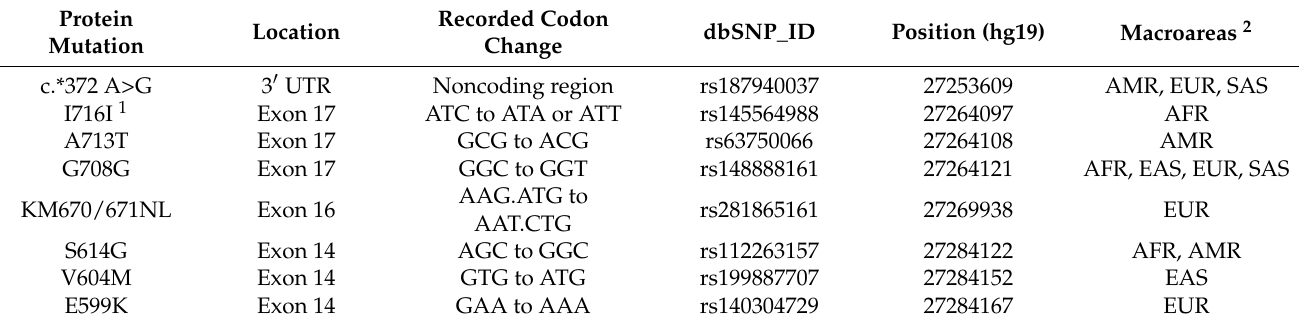
Table 1. APP point mutations detected in the worldwide